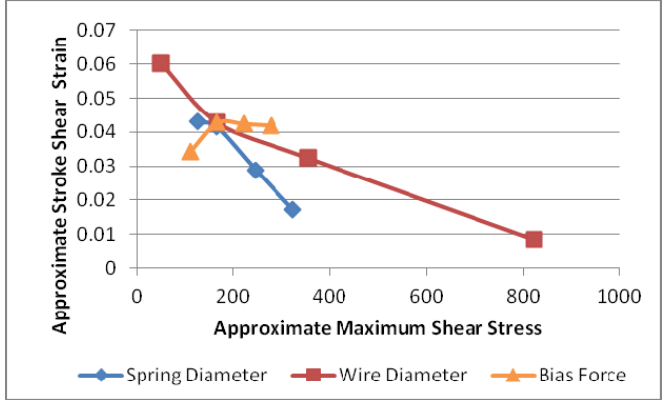
Figure 10. The approximate stroke shear strain vs. approximate maximum shear